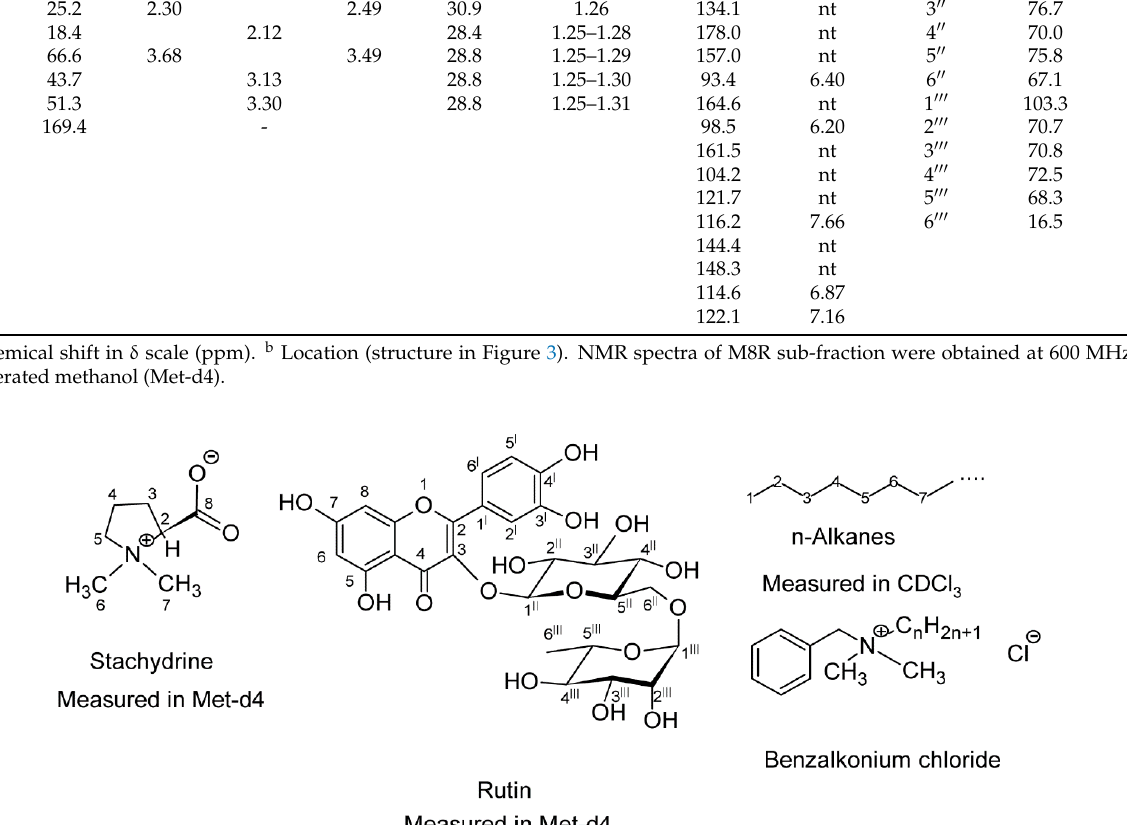
Table 2. NMR spectroscopic data a for the compounds present in M8R sub-fraction isolated from S. spinosum.